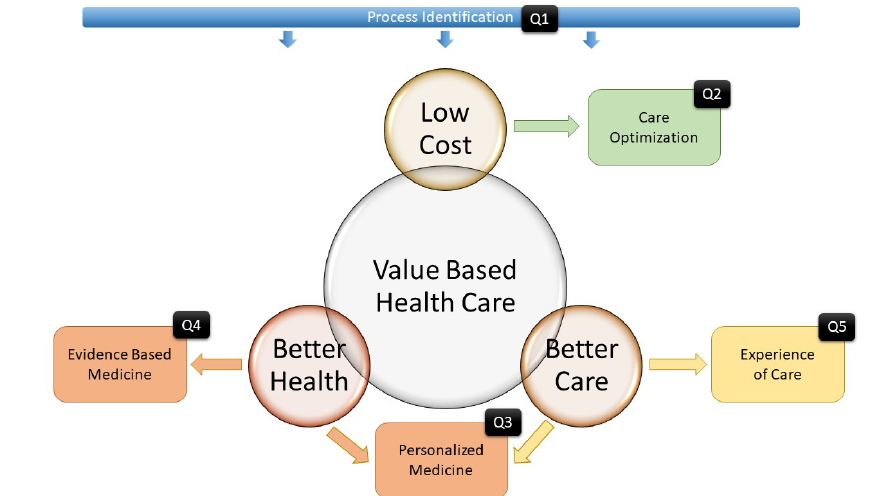
Figure 18. Value-based Healthcare and Triple Aim paradigms related to the research